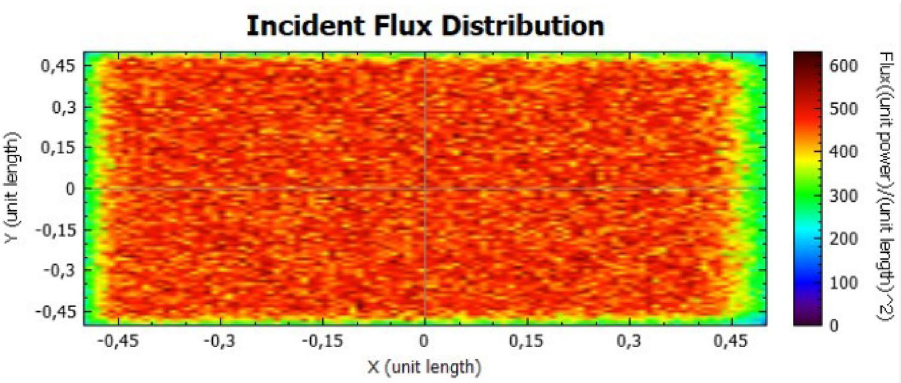
Figure 15. Incident Flux Distribution for an optical error of 0.010 (Flat Concentrator; 47% of reflectivity).